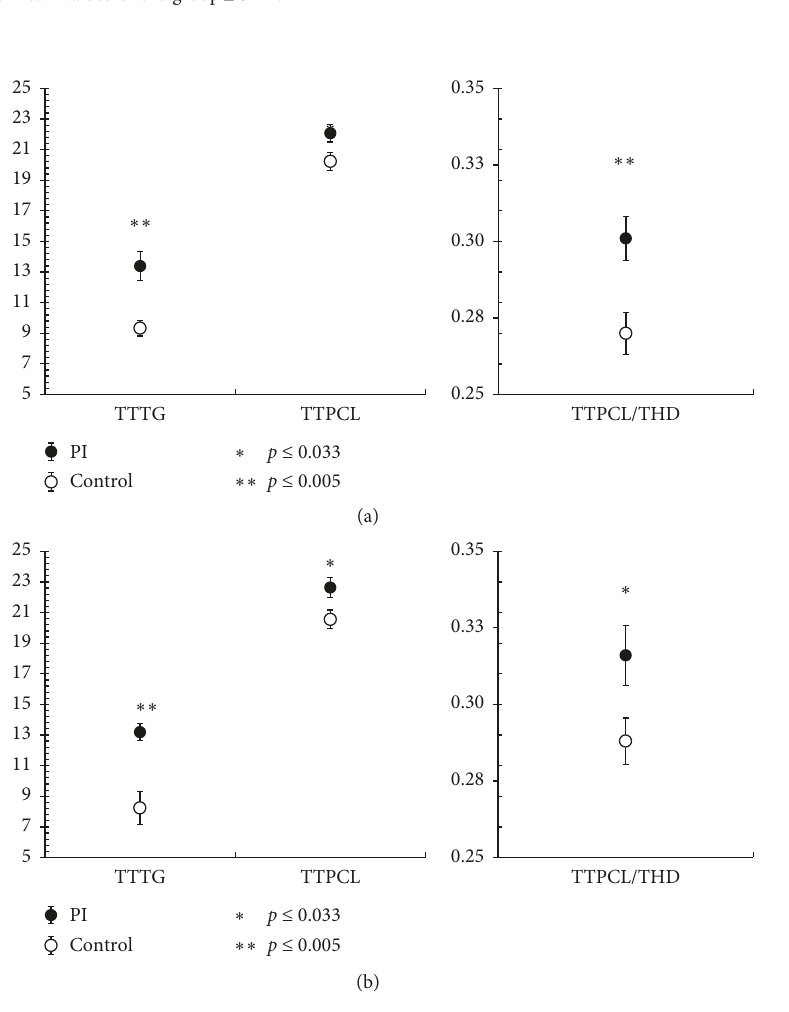
Figure 2: Graphs illustrating the TTTG, TTPCL, and TTPCL/THD for the control and patellar instability (PI) groups for adults (a) and children (b). The results are expressed as the mean values of the group ± the standard error of the mean (SEM).